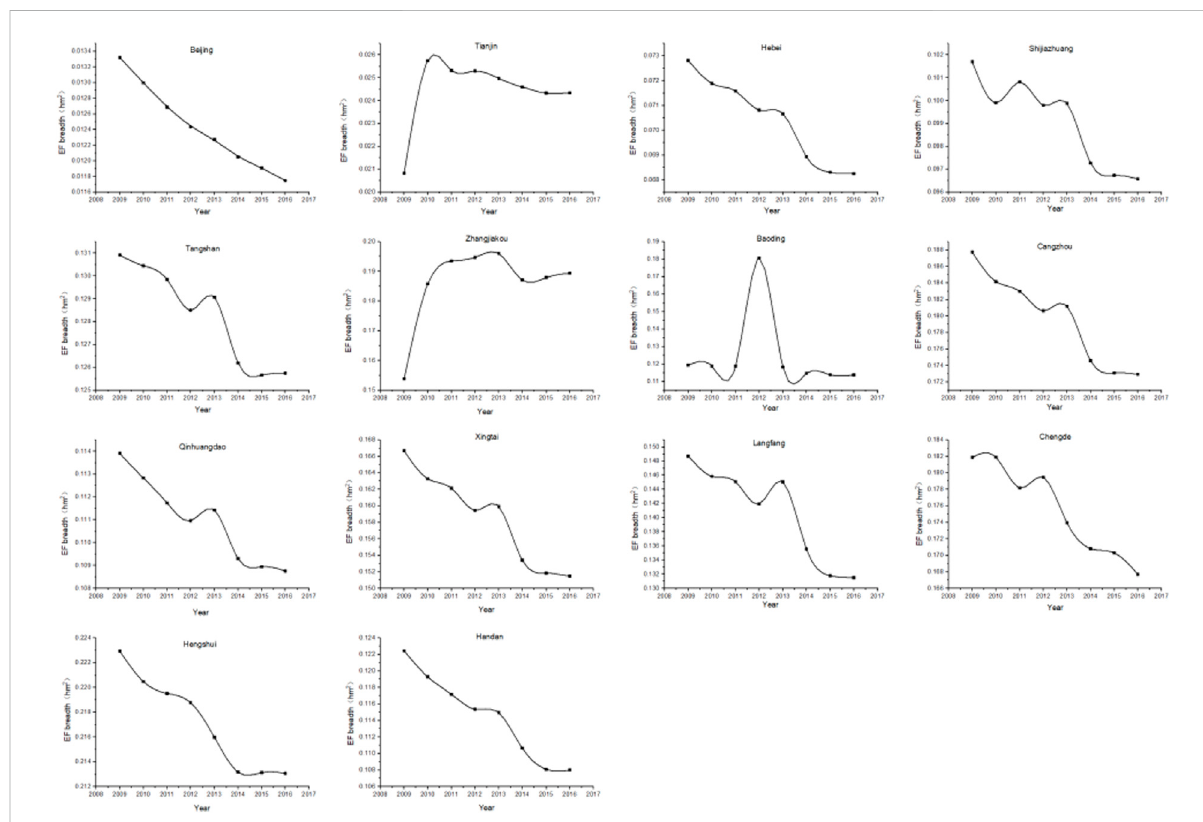
FIGURE 5 The trend of ecological footprint breadth of cultivated land in Beijing-Tianjin-Hebei